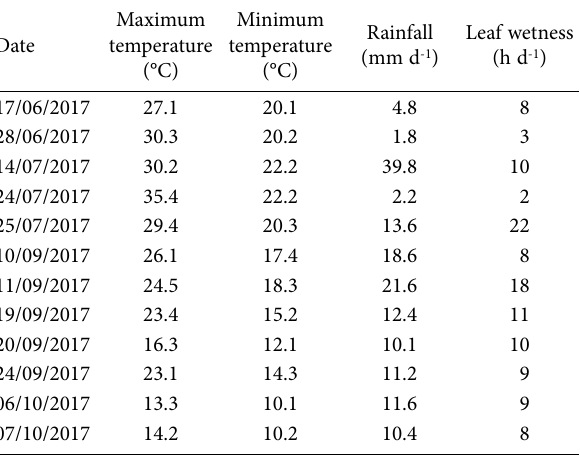
Table 5. Rainfall, temperature and leaf wetness periods on rainy days of the CSA vineyard in 2017.